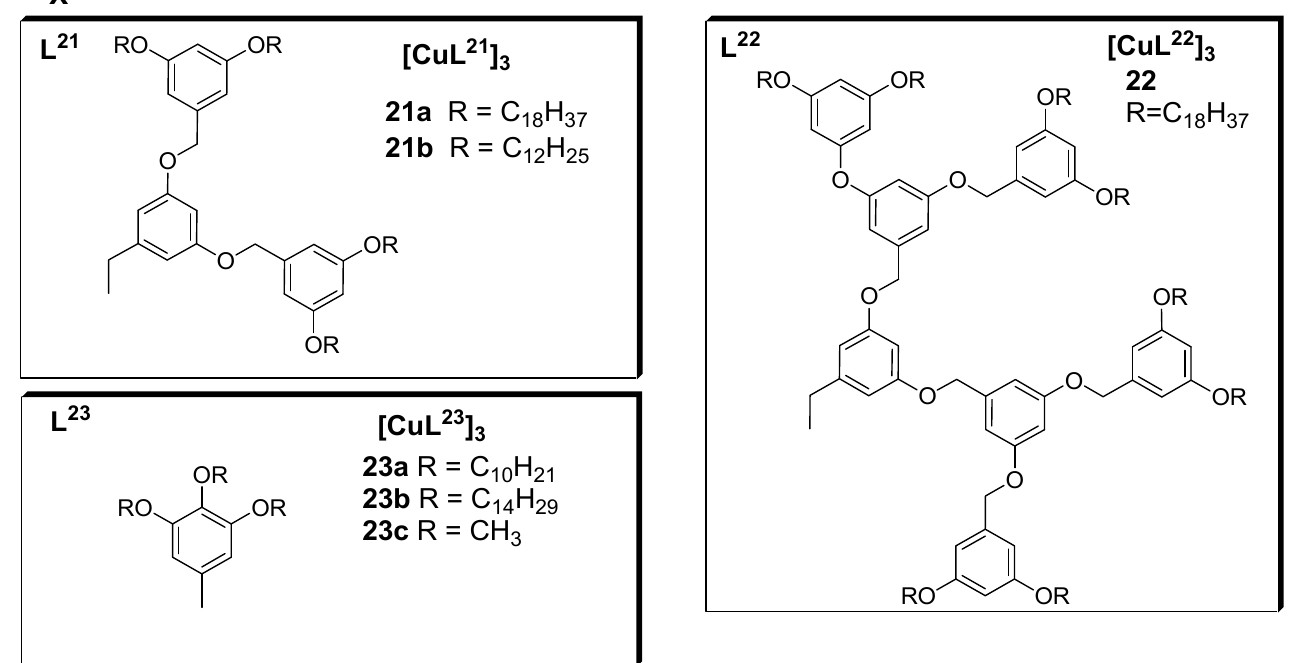
Figure 7. Ligands and representative structure of the copper pyrazolate complexes reported in [57,58].